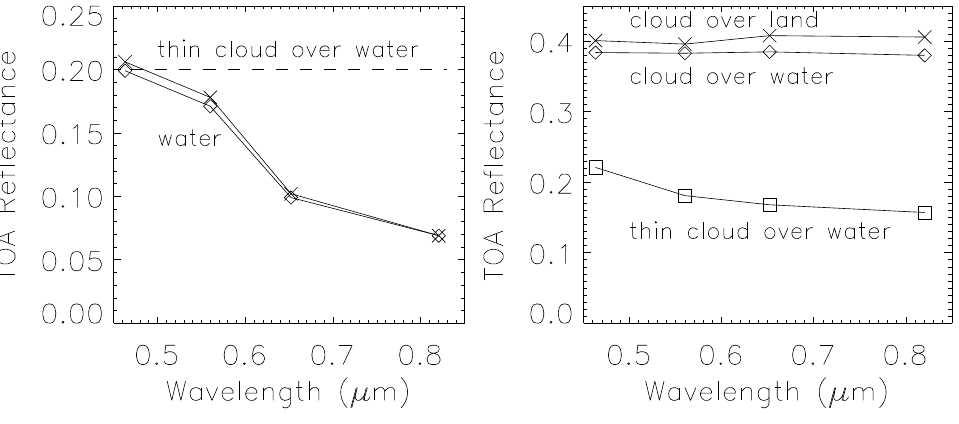
Figure 6 . TOA reflectance spectra of cloud, cloud over water, and water from Figure 5.